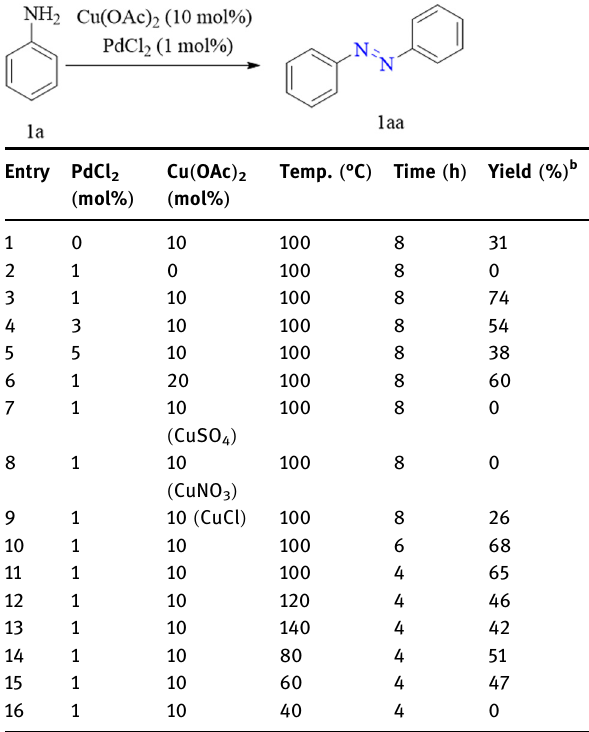
Entry PdCl 2 ( mol% )